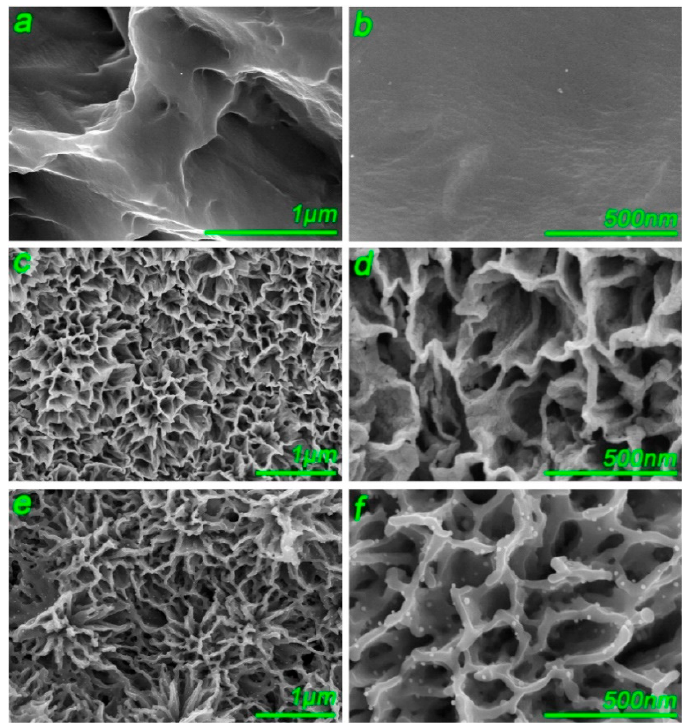
Figure 8. Surface morphology of the designed samples micro-Ti ( a , b ), nano-Ti ( c , d ) and Ag-Ti ( e , f ) [62]. Reprinted with permission from reference [62] 2016 Elsevier.